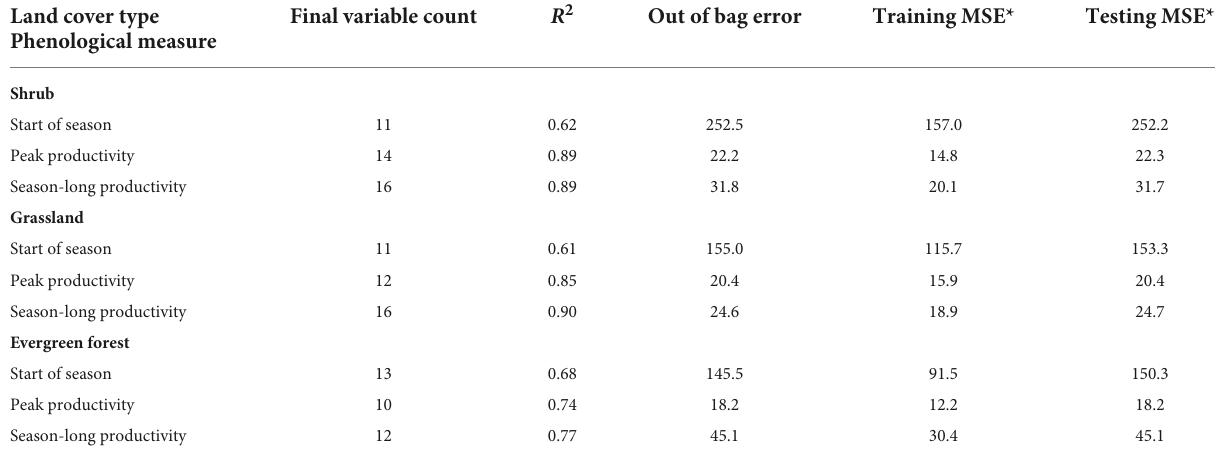
TABLE 1 Model performance using Random Forests analyses for identification of the most predictive climate, soil, and disturbance variables on three phenology measures, across three dominant, natural land-cover types. Land cover type Phenological